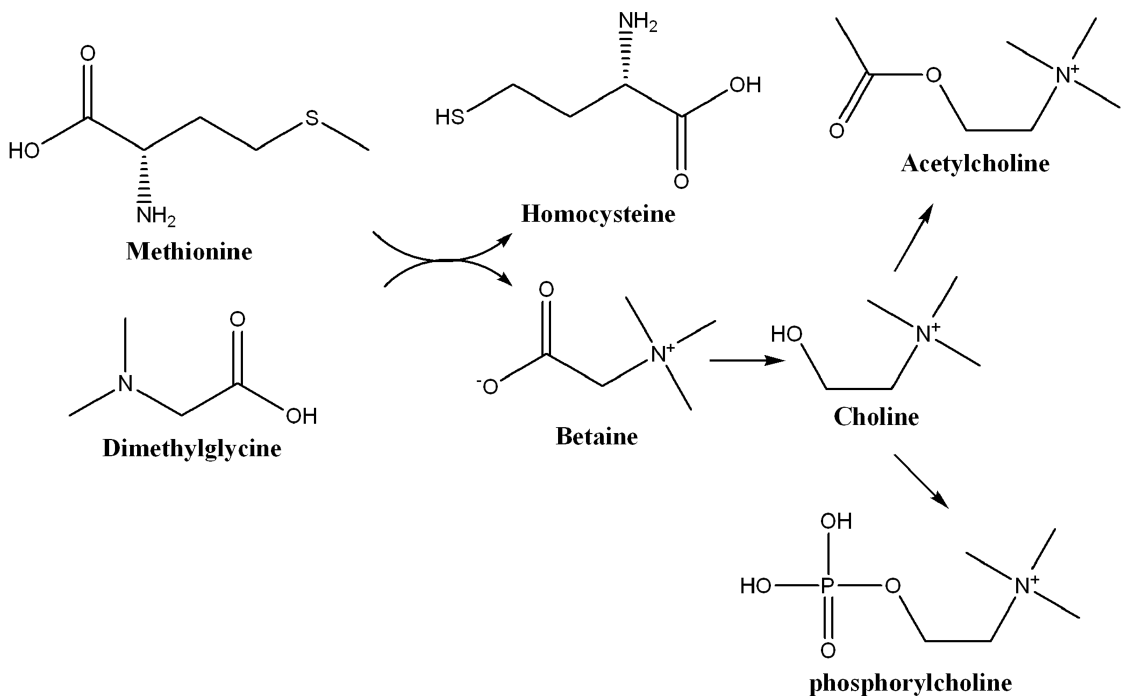
Figure 6. Schematic of acetylcholine biosynthesis in the central nervous system. Acetylcholine was found to be elevated in the both three weeks post-recovery male and female Balb/C mice infected with Plasmodium chabaudi . In addition, the female mice showed elevation in the level of phosphorylcholine and decrease in methionine.